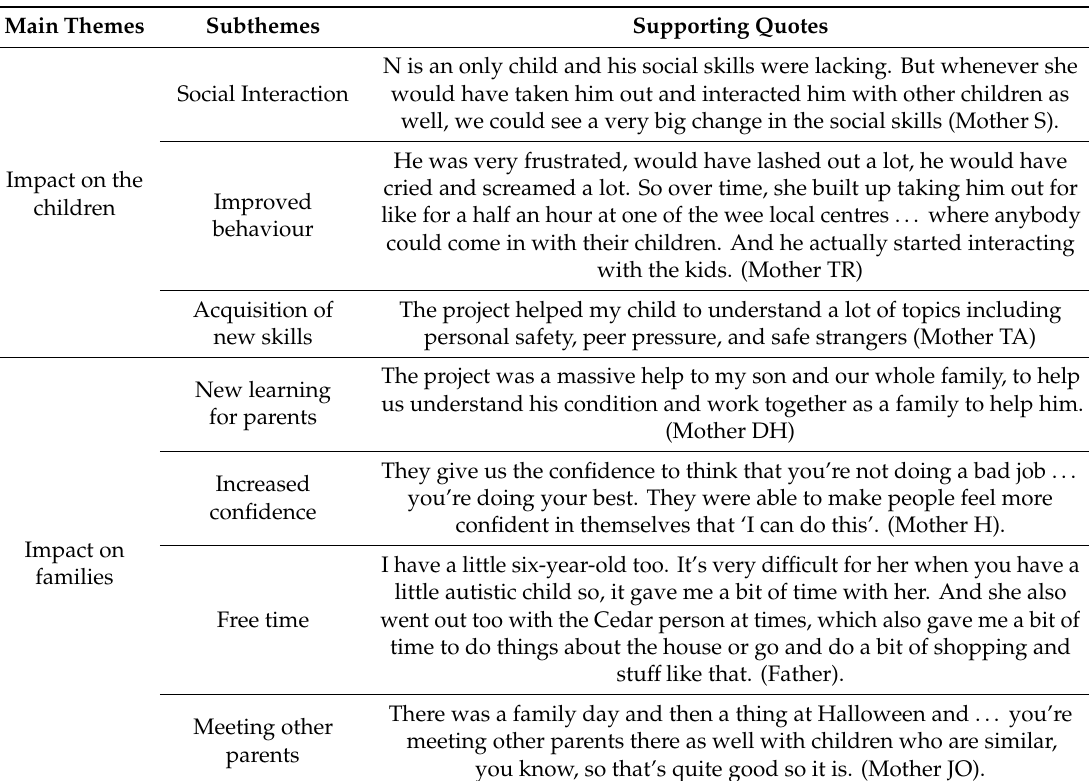
Table 3. The themes and subthemes reported as outcomes of the project by